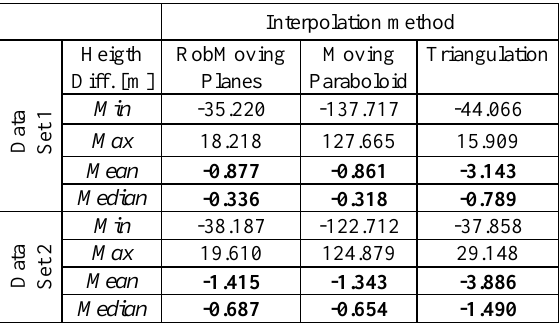
Table 2. Height difference between DRM 4G and DTMs The histograms A, B and C show height differences from comparison DMR 4G and data set 1, the histograms D, E, F –